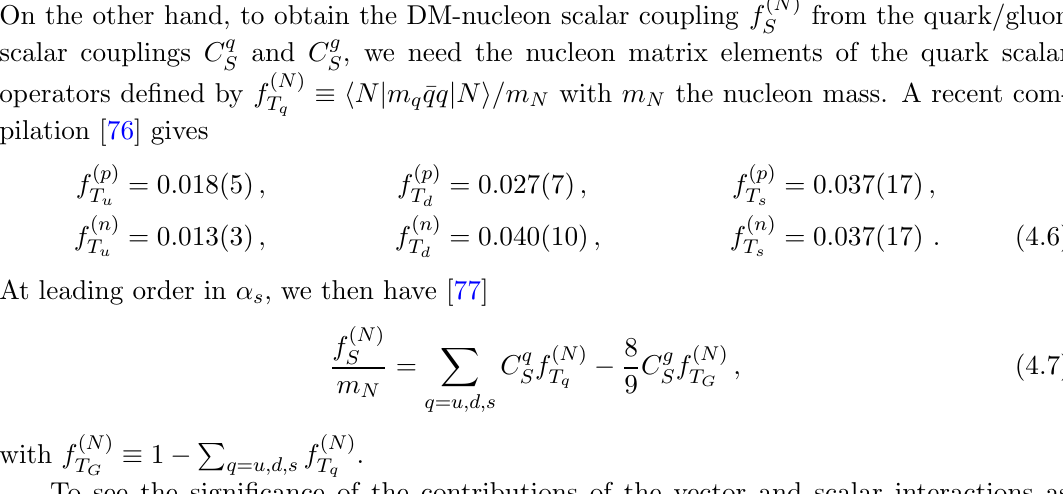
Figure 5 . Green, red, blue, and black lines show the absolute values of f ( p ) eC (cid:13) = (2 m (cid:31) ) as functions of the DM mass, respectively, with the minus sign indicated if the corre- M sponding quantity is negative. Here we take the same parameter sets as in (cid:12)gure